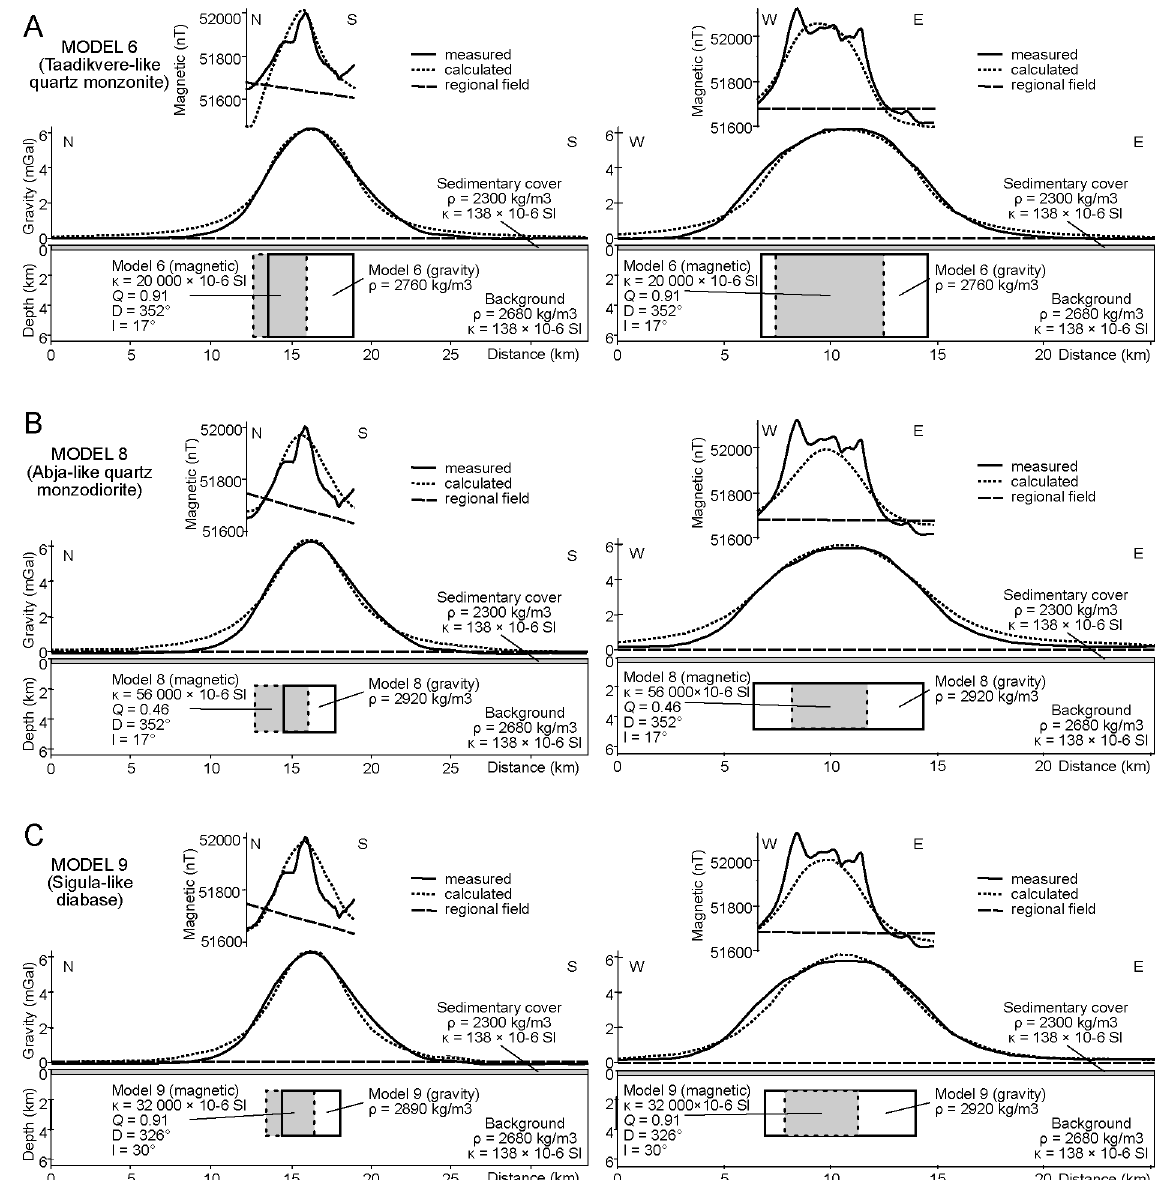
Fig. 5. Magnetic and gravity models 6 ( A ), 8 ( B ) and 9 ( C ) (Table 1). The left side represents the north–south-oriented, the right side east–west-oriented profile, respectively. Every model (bottom subfigure) includes magnetic (top subfigure) and gravity (middle subfigure) profile data providing information on measured, calculated and regional